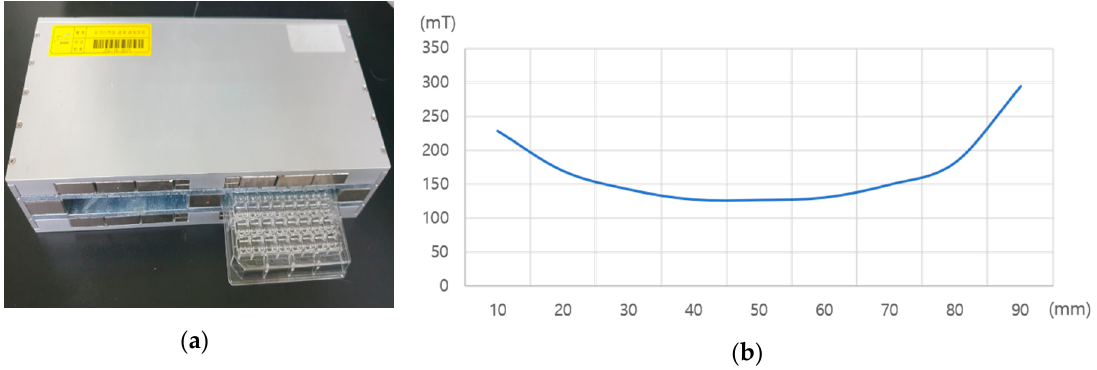
Figure 3. The new devices consist of a simple cassette in which the rod magnets are compactly packed into an aluminum frame and covered by carbon steel and aluminum plates. ( a ) Disassembled and assembled positions of the device. ( b ) Graphic representation of magnetic field density vs. distance.